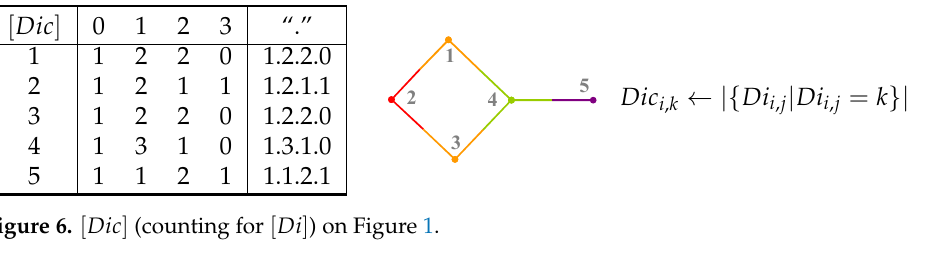
Figure 5. [ Adc ] (counting for [ Ad ] ) on Figure 1.